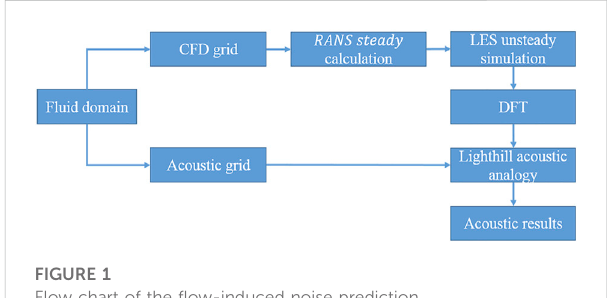
FIGURE 1 Flow chart of the fl ow-induced noise